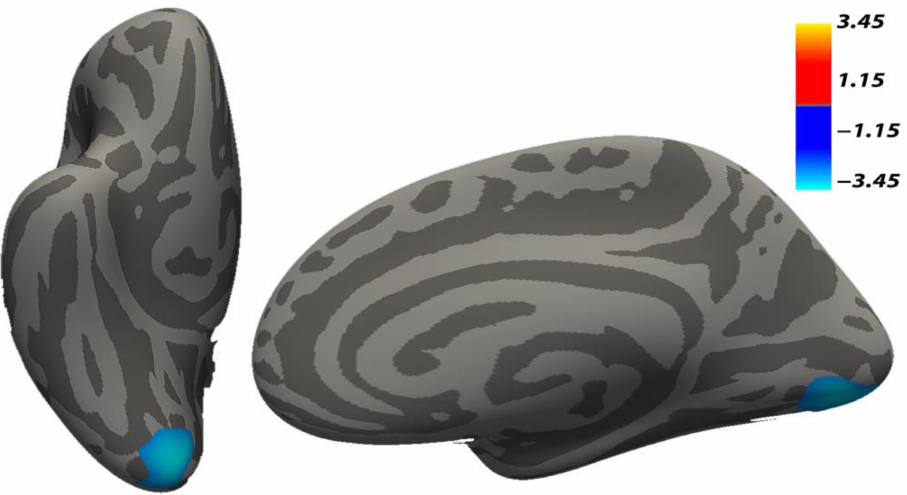
Figure 2. The increased cortical surface area in Neglect versus Control groups. The cluster comprises lingual and lateral occipital regions. Background brain images represent the inferior ( left image) and medial ( right image) views of the right inflated hemisphere (FreeSurfer) fsaverage brain. Note: p < 0.05 cluster-wise corrected, 10,000 Monte Carlo iterations, age, total intracranial volume (TIV) and Psychiatric Disorders were used as nuisance covariates for the cortical surface area